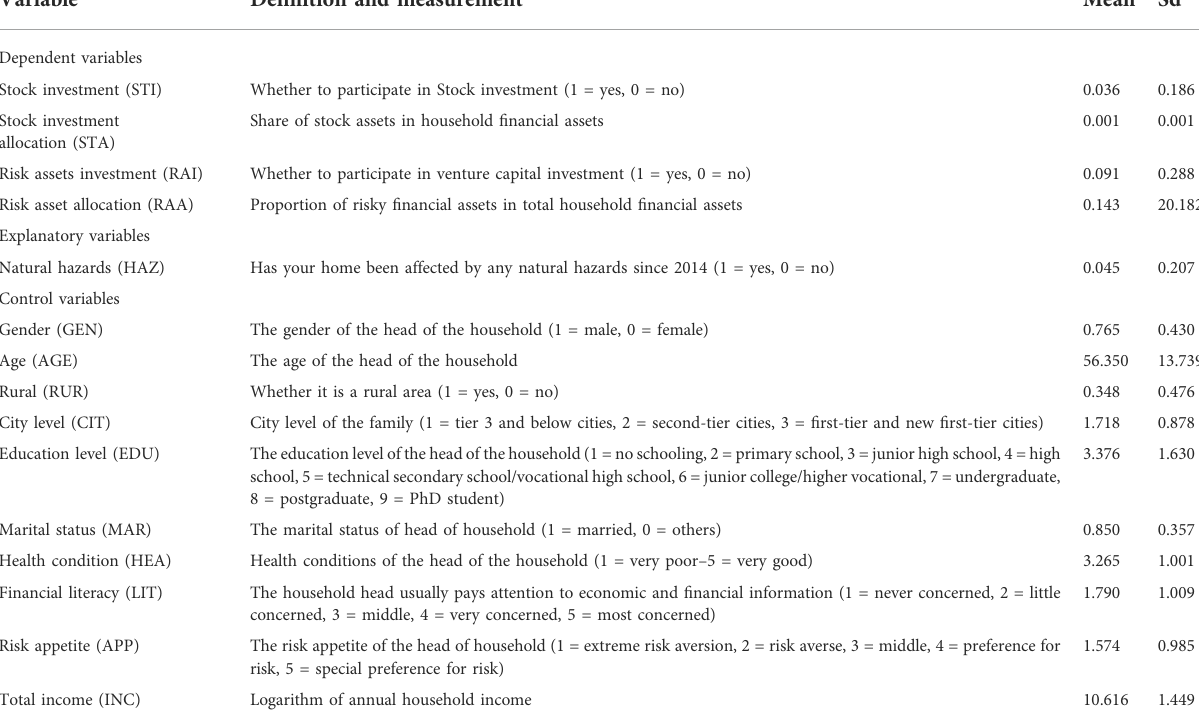
TABLE 1 Description of each variable and descriptive